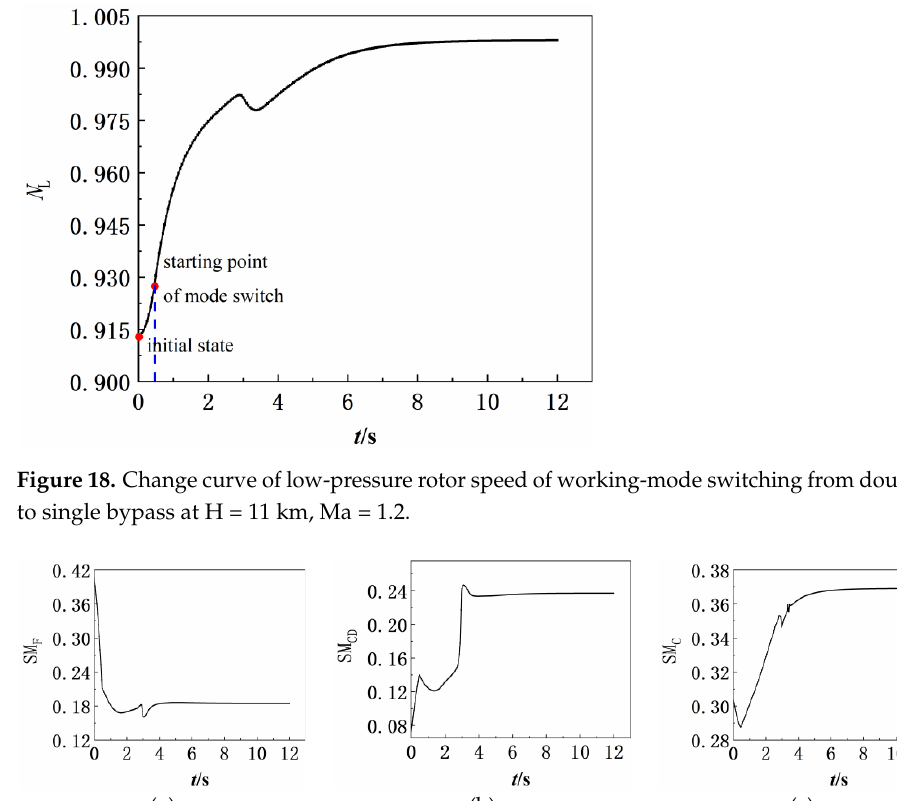
Figure 17. Change curve of thrust of working-mode switching from double bypass to single by- pass at H = 11 km, Ma = 1.2.